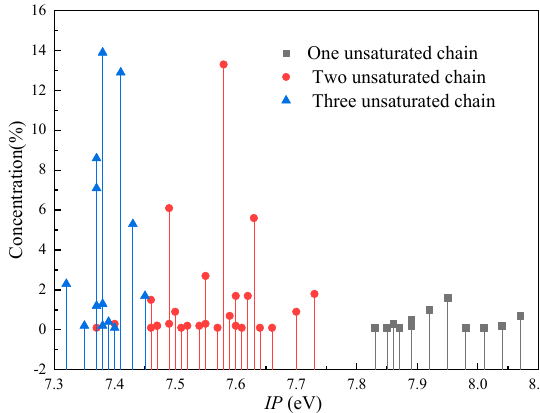
Figure 7. The distribution of the IP of the natural ester oil.